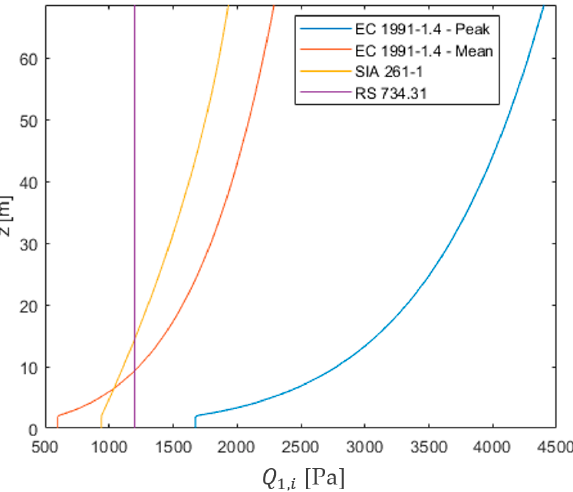
Figure 17. Comparison of different design standards’ pressure distributions [7,8,25].